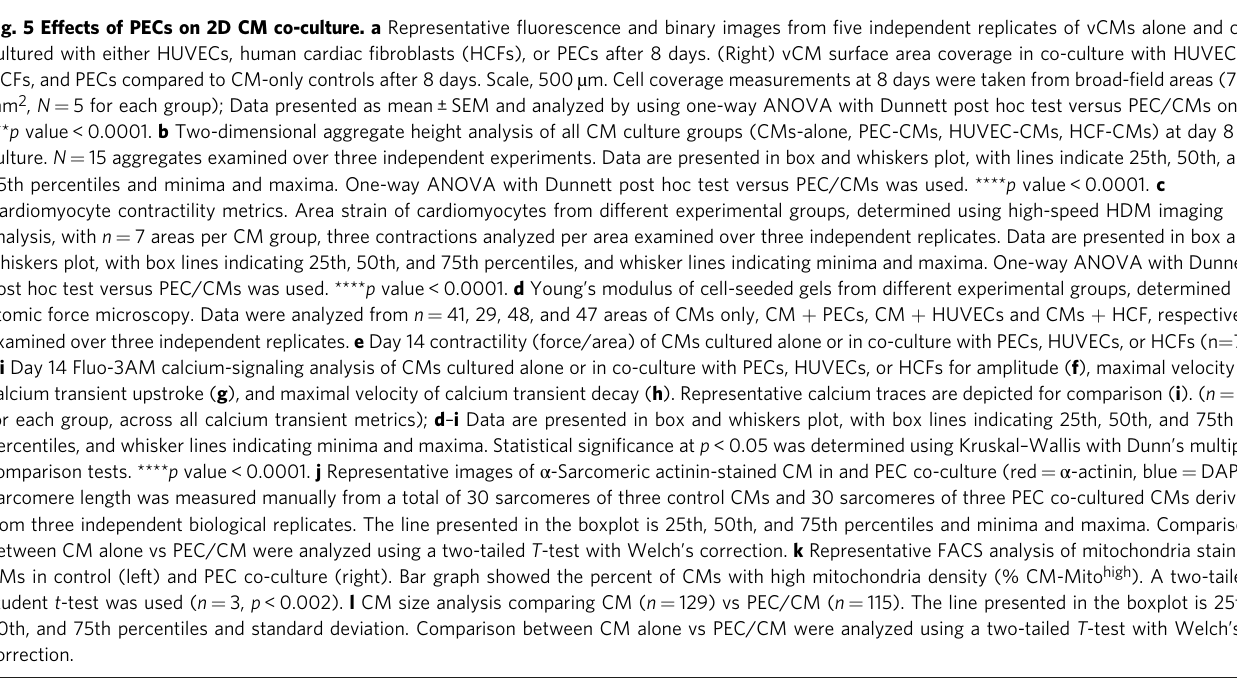
percentiles, and whisker lines indicating minima and maxima. Statistical signi fi cance at p < 0.05 was determined using Kruskal – Wallis with Dunn ’ s